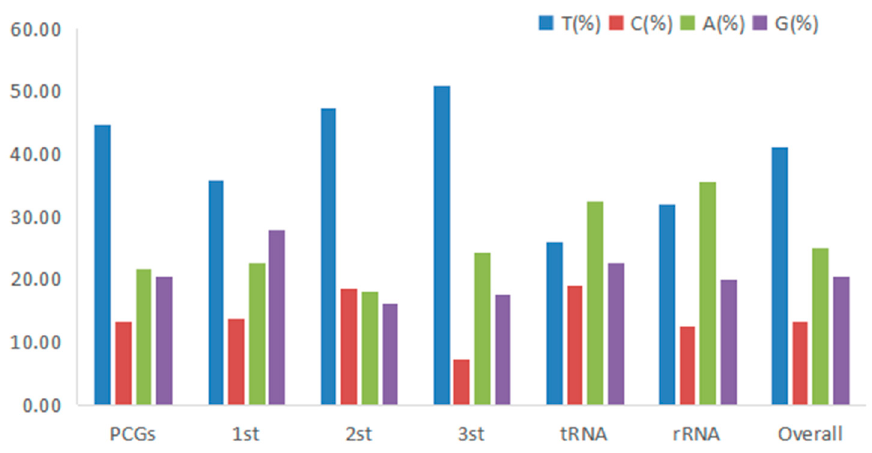
Figure 3. Codon usage bias in different regions of the mitogenome of H. bowerbanki . Table 2. Organization of the mitogenome of H. bowerbanki .